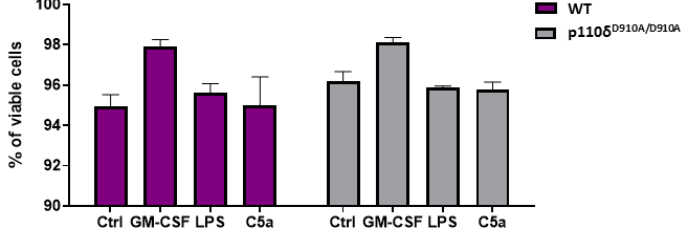
Figure 3. Functional knock-out of p 110δ did not alter survival time of granulocytes. Isolated granu- locytes were cultured in the presence of lipopolysaccharides isolated from E. coli (LPS), GM-CSF